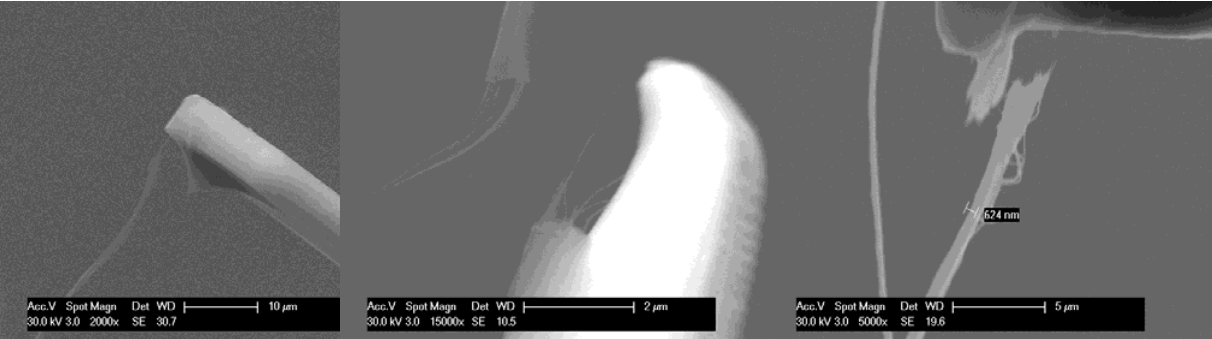
Figure 4. Different positions for pulling thread: ( a ) a ribbon with junctions mostly aligned which will produce weak thread; ( b ) a ribbon with junctions distributed evenly which will produce strong thread; ( c ) thread formed using the distributed method top to bottom in ( b ); ( d ) thread formed using the aligned top to bottom method in ( a